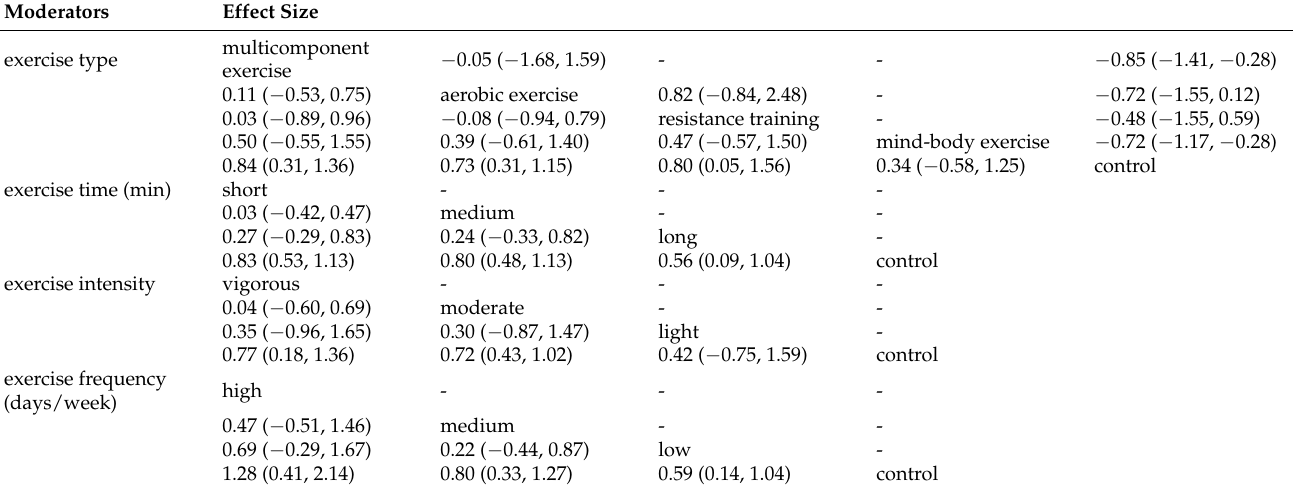
Table 3. Ranking table of exercise